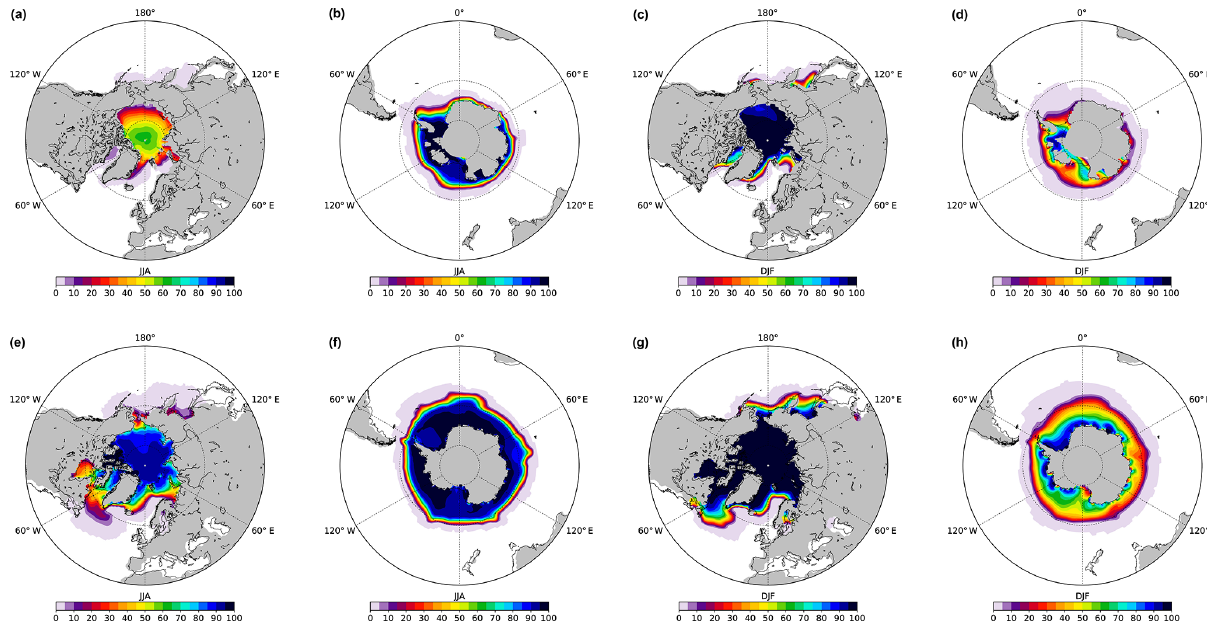
Figure 16. Surface area covered by sea ice for the mid-Pliocene (cid:104) 2691 , 2720 (cid:105) (a–d) and PI control (cid:104) 5131 , 5160 (cid:105) (e–h) . The climatological mean for the austral winter months JJA is presented in the first two columns, and the boreal winter months DJF are in the last two columns. The (cid:104)(cid:105) denotes the range of model years over which the climatology was